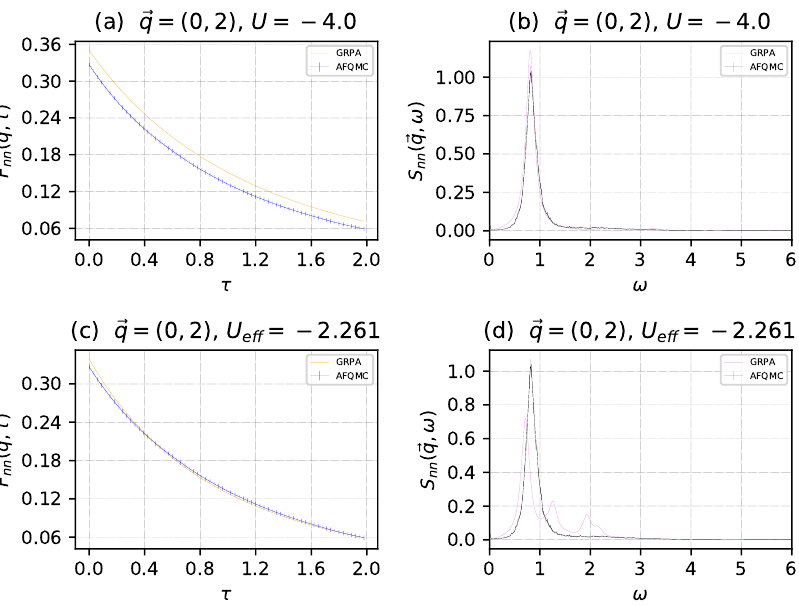
Figure 4. For momenta q = ( 0,2 ) , in units of 2 π : The density–density, imaginary-time intermediate L scattering function F nn ( q , τ ) for the physical potential U = − 4.0 ( a ). The density–density dynamical structure factor S nn ( q , ω ) for the physical potential U = − 4.0 ( b ). The density–density, imaginary- time intermediate scattering function F nn ( q , τ ) for the renormalized, effective potential U ef f = − 2.261 ( c ). The density–density dynamical structure factor S nn ( q , ω ) for the renormalized, effective potential U ef f = − 2.261 ( d ). In the left sub-panels, blue indicates AFQMC data and orange indicates GRPA data. In the right sub-panels, black indicates AFQMC data and violet indicates GRPA data.